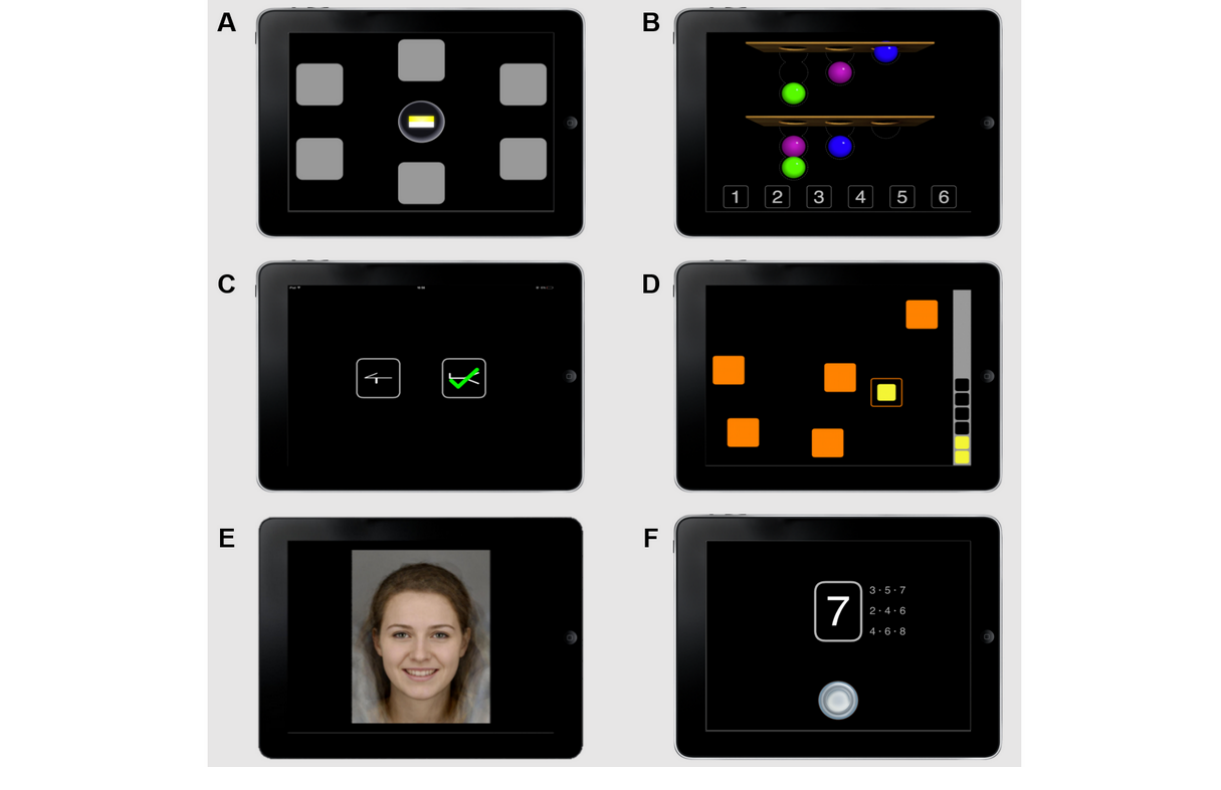
Figure 1. Screenshots of Cambridge Neuropsychological Test Automated Battery tests administered: (A) Paired Associate Learning, (B) One Touch Stockings of Cambridge, (C) Pattern Recognition Memory, (D) Spatial Working Memory, (E) Emotion Recognition Task, and (F) Rapid Visual Information